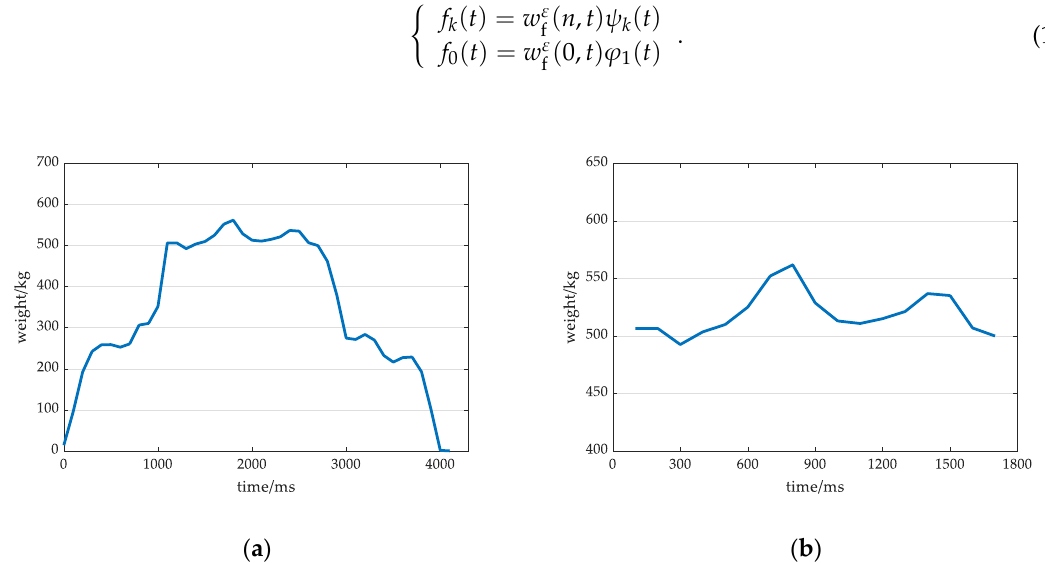
Figure 5. Original weight signal and valid signal at a medium grade of active degree: ( a ) Original weight signal at a medium grade; ( b ) Valid signal at a medium grade.